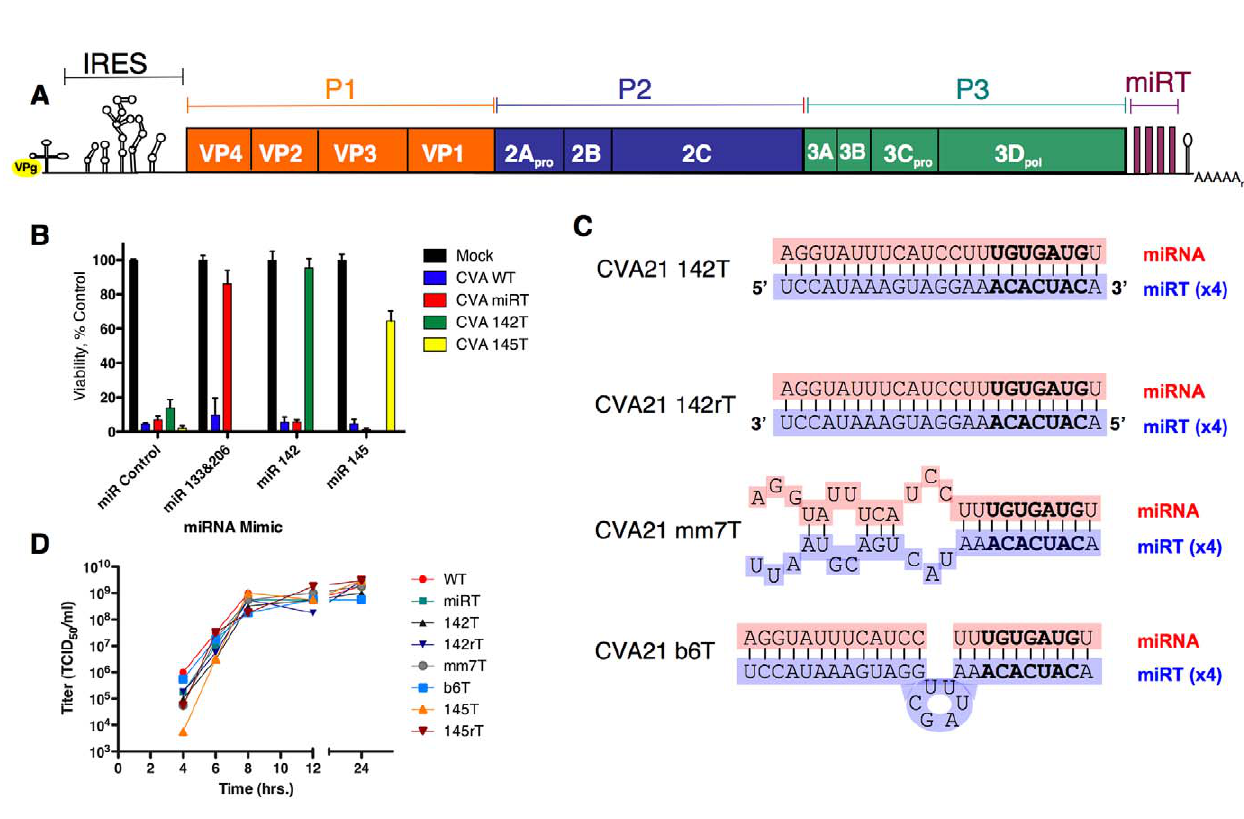
Figure 1. Schematics, growth kinetics, and permissivity of recombinant CVA21 in HeLa cells. (A) Schematic diagram of microRNA insertion in CVA21. (B) Viability of HeLa cells transfected with indicated miRNA-mimics 48 hours post infection with indicated recombinant CVA21. (C) Schematic overview of miRNA/target homology of recombinant inserts. (D) One -step growth curves of recombinant CVA21s on HeLa cells.